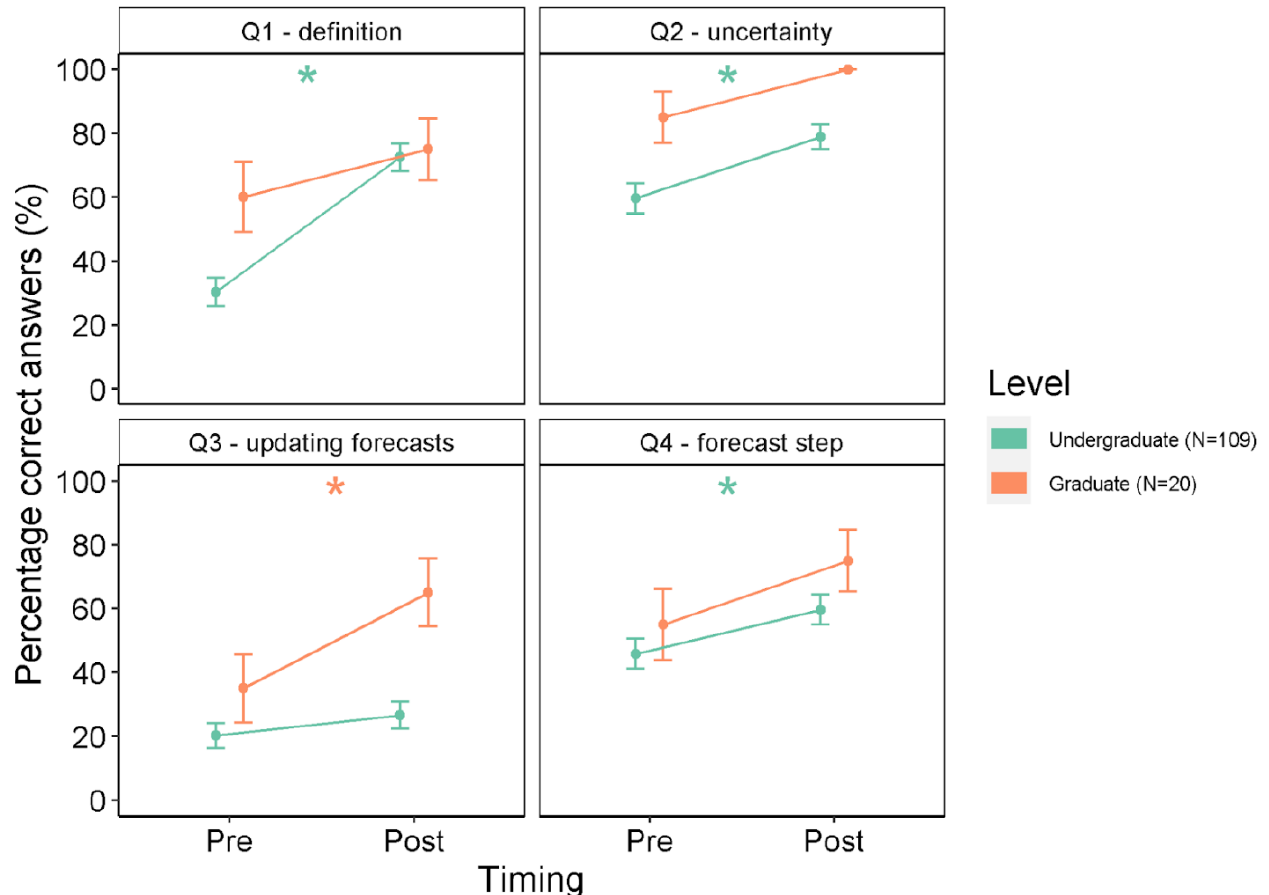
Figure 3. Percentage of students who answered questions 1–4 (Q1–4) correctly in the pre- and post- module assessments for undergraduate (n = 109) and graduate students (n = 20). Stars (*) indicate statistically significant ( p < 0.05) differences between pre- and post-module assessments, color-coded for undergraduate or graduate students (see statistical results in Table A7). The questions and their responses are provided in Table A2.